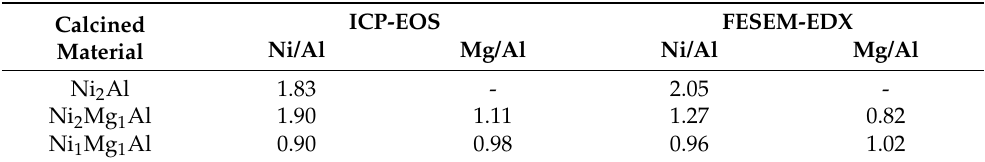
Table 1. Atomic ratios of the LDH precursors calcined at 400 ◦ C for 4 h, measured by ICP-EOS and